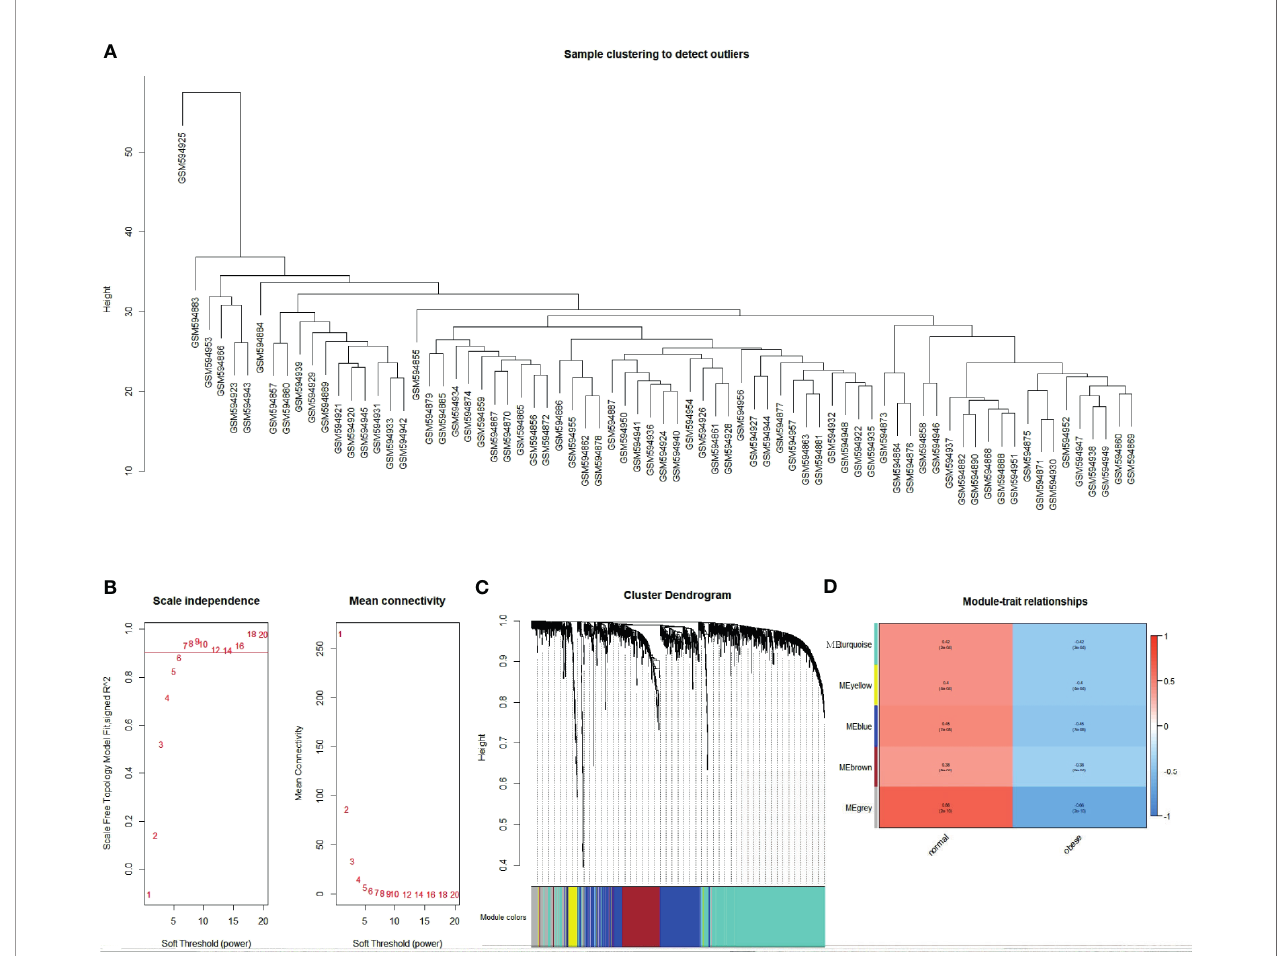
FIGURE 2 | Identi fi cation of the functional modules associated with obesity. (A) Cluster dendrogram; (B) Analysis of network topologies for various soft threshold powers; (C) Clustering dendrogram of DEGs with dissimilarity based on topological overlap, together with assigned module colors; (D) Module-trait heatmap. Each row corresponds to a module eigengene, each column corresponds to a trait. Each cell contains the corresponding correlation and P